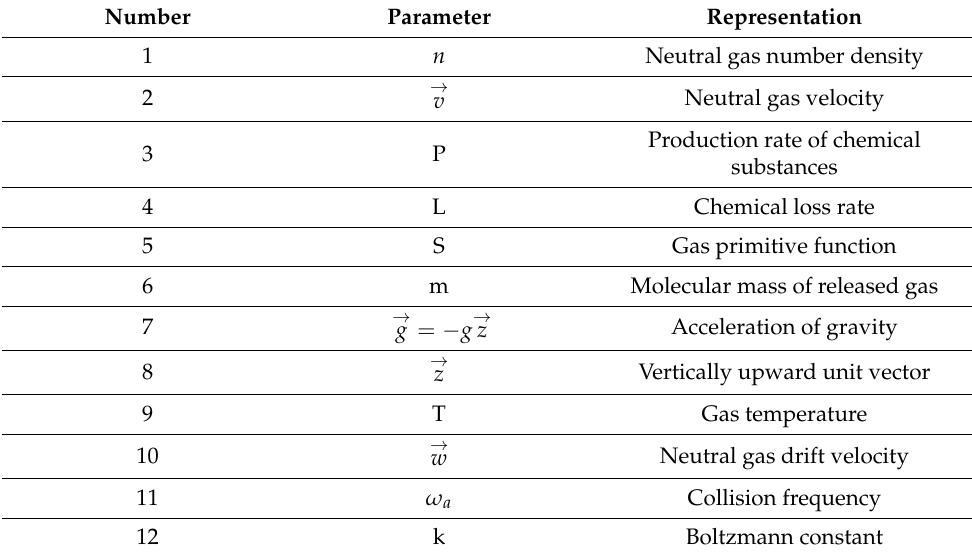
Table 1. The meaning of related parameters of the above Formulas (1) and (2).